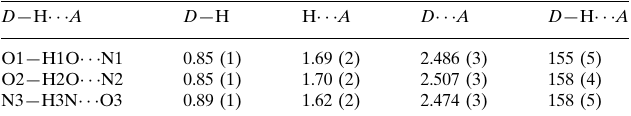
Hydrogen-bond geometry (A˚ , (cid:2)